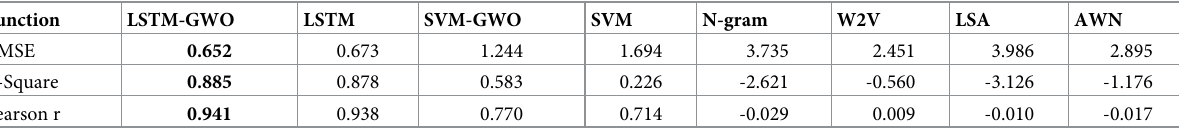
Table 10. Comparison of the proposed model and compared models with experiment 6.